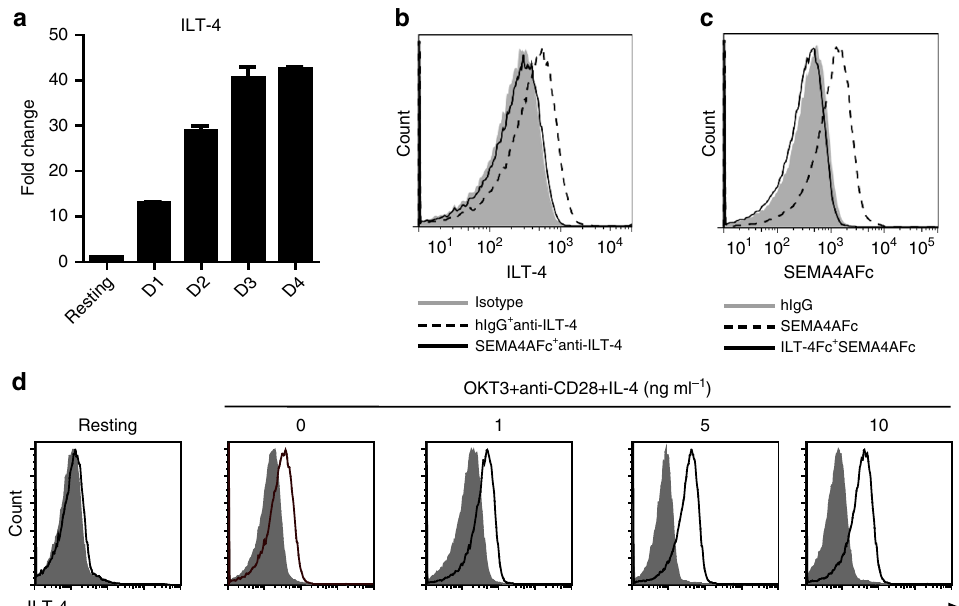
Fig. 5 ILT-4 is a receptor inducibly expressed on activated human CD4 + T cells for SEMA4A. a Expression of ILT-4 mRNA was induced in activated CD4 + T cells. The expression levels of ILT-4 mRNA were detected by real-time PCR in freshly puri fi ed human naive CD4 + T cells or Tn cells activated with immobilized OKT3 and soluble anti-CD28 mAb for the indicated day1, day 2, day 3, and day 4, respectively. The relative fold differences in gene expression between samples are indicated on the y -axis. Error bars represent the s.e.m. of different wells. Data represent one of four independent experiments. b SEMA4A-Fc blocks the binding of anti-ILT-4 mAb to activated CD4 + T cells. Puri fi ed naive CD4 + T cells were activated with immobilized anti-CD3, anti- CD28 mAb for 1 day. Cells were stained with isotype control antibody ( fi lled area), anti-ILT-4 mAb plus hIgG (dashed line), or an excess of SEMA4A- Fc plus anti-ILT-4 mAb (full line), and analyzed by fl ow cytometry. Data represent one of fi ve independent experiments. c ILT-4-Fc blocks the binding of SEMA4A-Fc to activated CD4 + T cells. Puri fi ed naive CD4 + T cells were activated with immobilized anti-CD3, anti-CD28 mAbs for 1 day. Cells were stained with hIgG ( fi lled histogram), SEMA4A-Fc (dashed line) or an excess of ILT-4-Fc and SEMA4A-Fc (full line), and analyzed by fl ow cytometry. Data represent one of fi ve independent experiments. d IL-4 enhances ILT-4 expression on activated T cells. Puri fi ed naive CD4 + T cells were activated with immobilized anti-CD3 plus anti-CD28 mAbs in the absence or presence of IL-4 at the indicated concentrations for 7 days. ILT-4 expression was